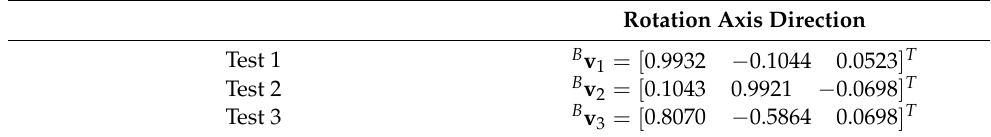
Table 4. Rotation axis directions estimated by RAMS.